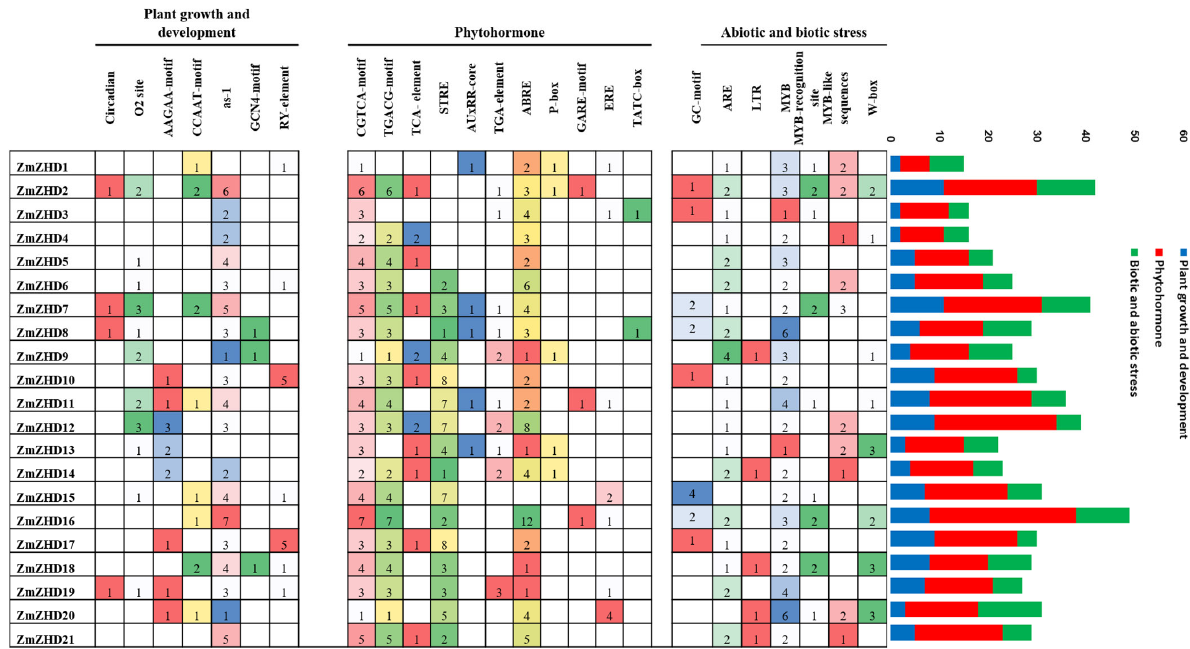
Figure 4. Cis ‐ acting elements identified in the promoter regions of ZmZHD genes. Figure 4. Cis-acting elements identified in the promoter regions of ZmZHD